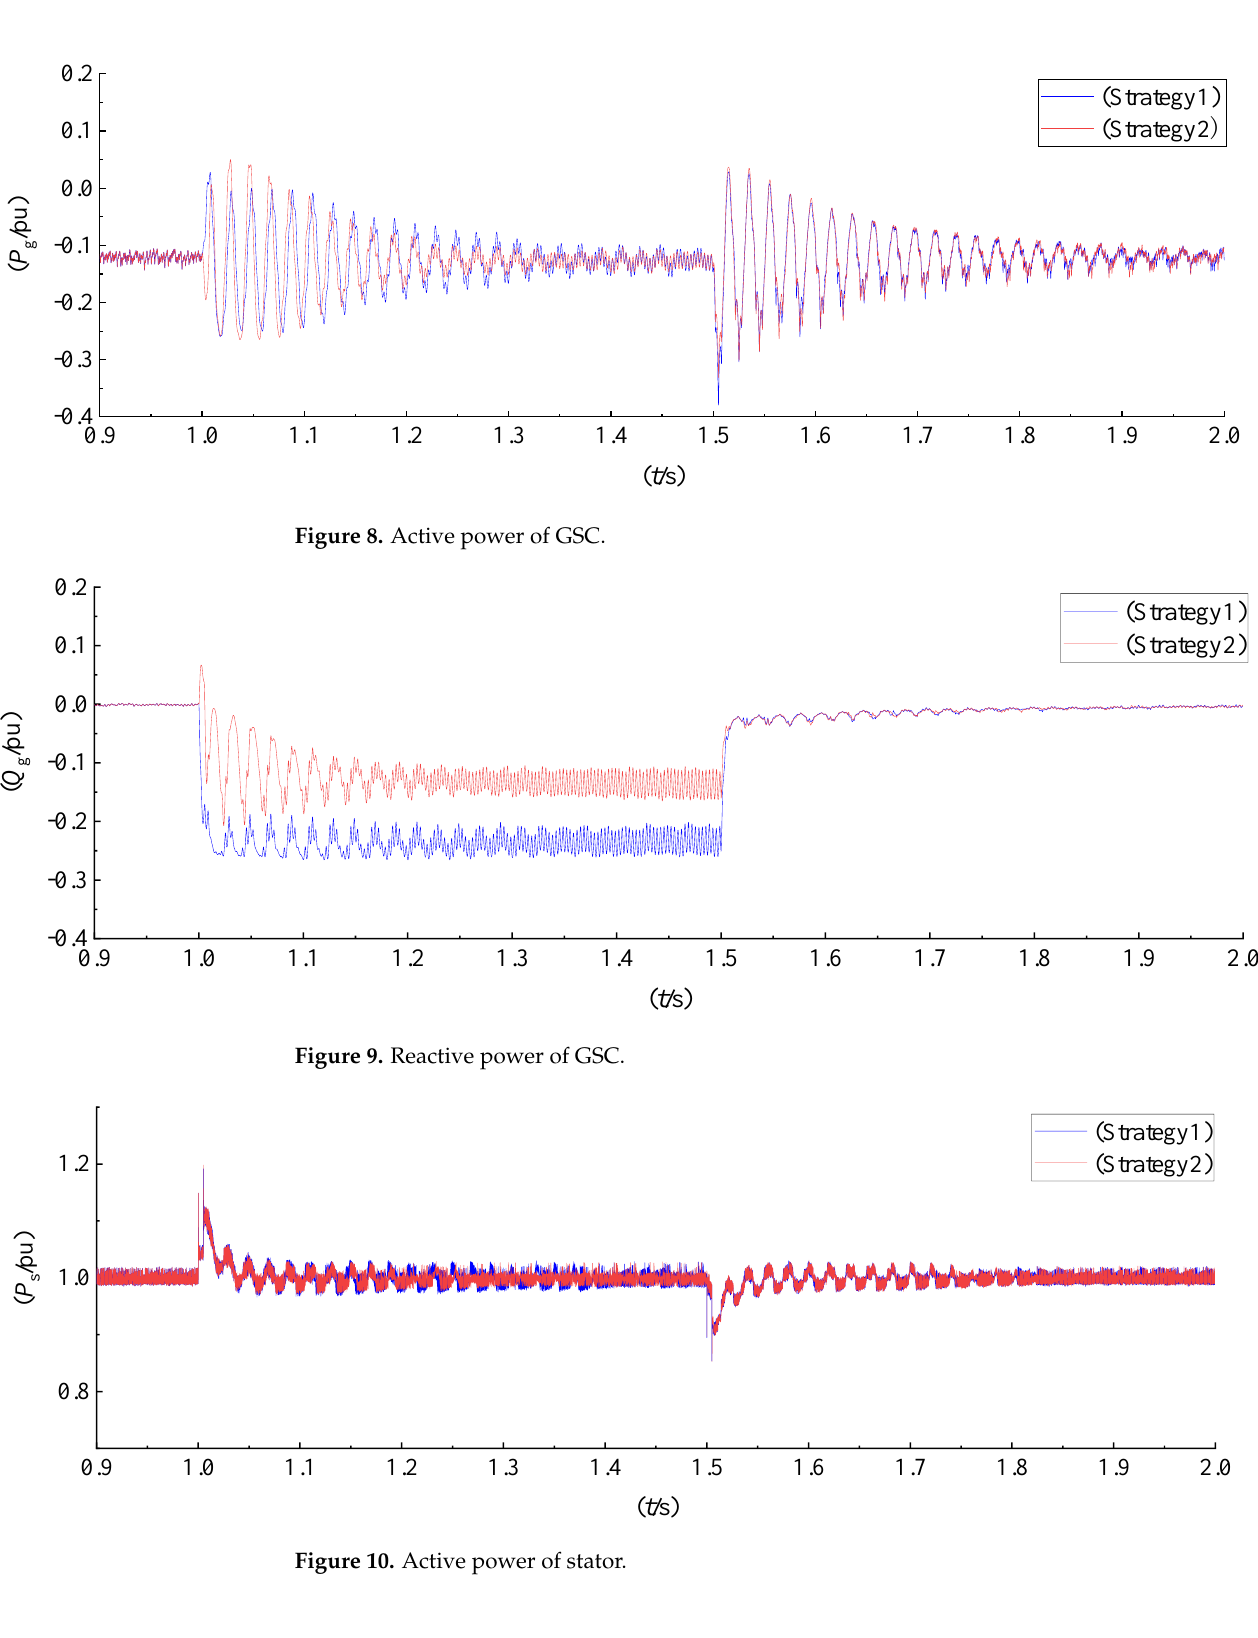
Figure 10. Active power of stator.